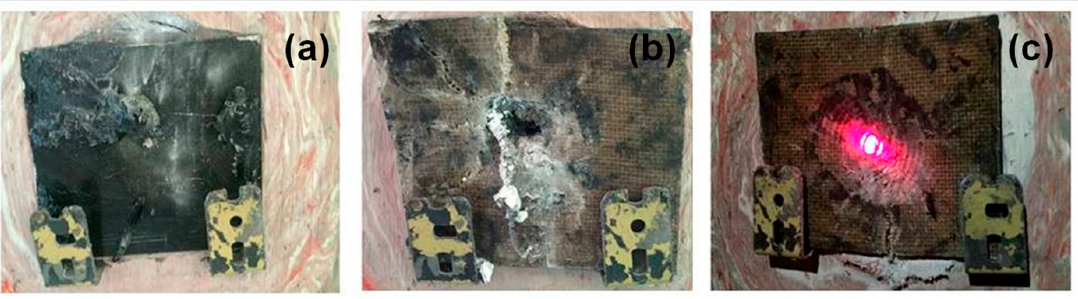
Figure 5. Typical aspect after ballistic test of multilayered armor system (MAS) targets with second